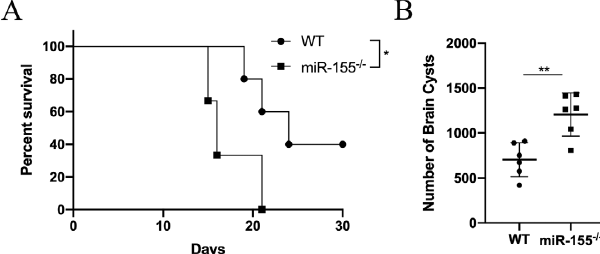
Figure 1. miR-155 de fi ciency enhanced cyst burden and reduced survival time in mice models. (A) Survival curves of mice after challenge of cysts of the PRU strain. miR-155 (cid:1) / (cid:1) mice had 0% survival at day 17. (B) Cyst loads were counted from whole brain homogenates of mice 4 weeks after challenge. The bars represented the mean cyst burden per mouse brain after challenge orally with a dose of 10 cysts of the PRU strain. Data are mean ± SD (representative of three experiments). ** p < 0.01; * p < 0.05, compared with the WT groups.